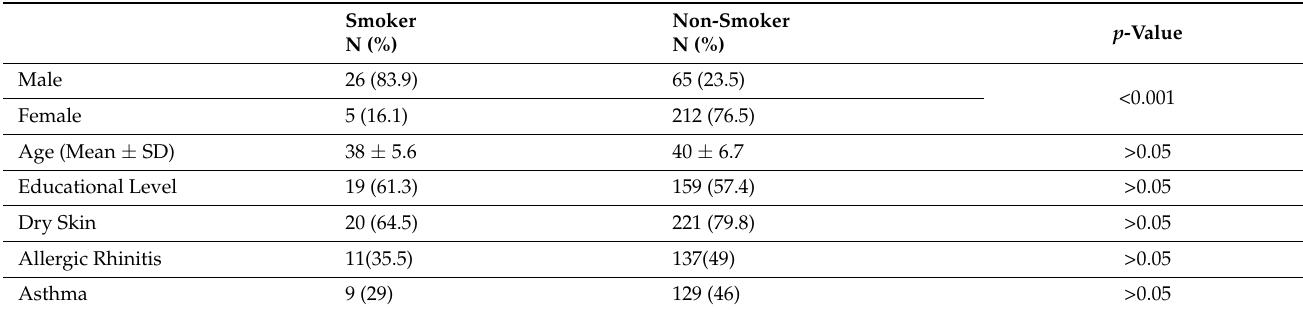
Table 1. Demographic data of the patients and their associated disorders.